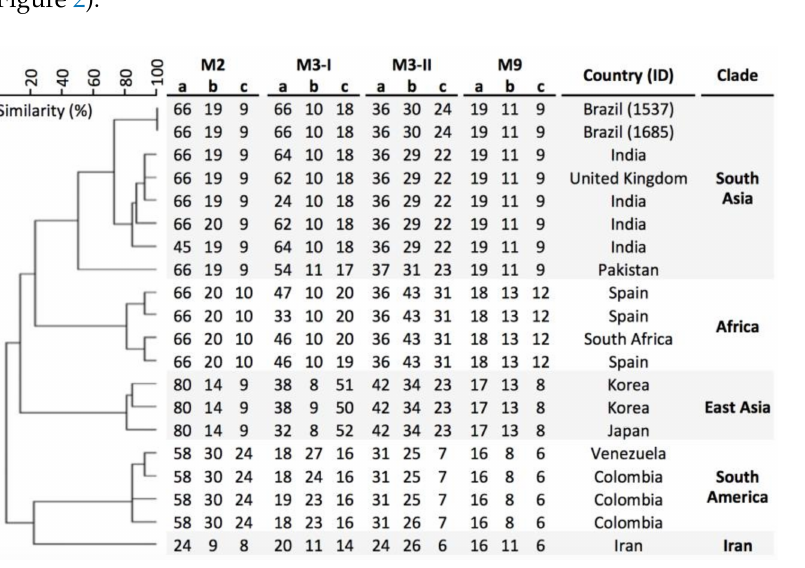
Figure 2. Short tandem repeat (STR) typing of C. auris isolates from Brazil. UPGMA dendrogram of the Brazilian (L1537/2020 and L1685/2020) and representative strains from South Asian and other four clades are shown. The scale in the upper left corner represents similarity